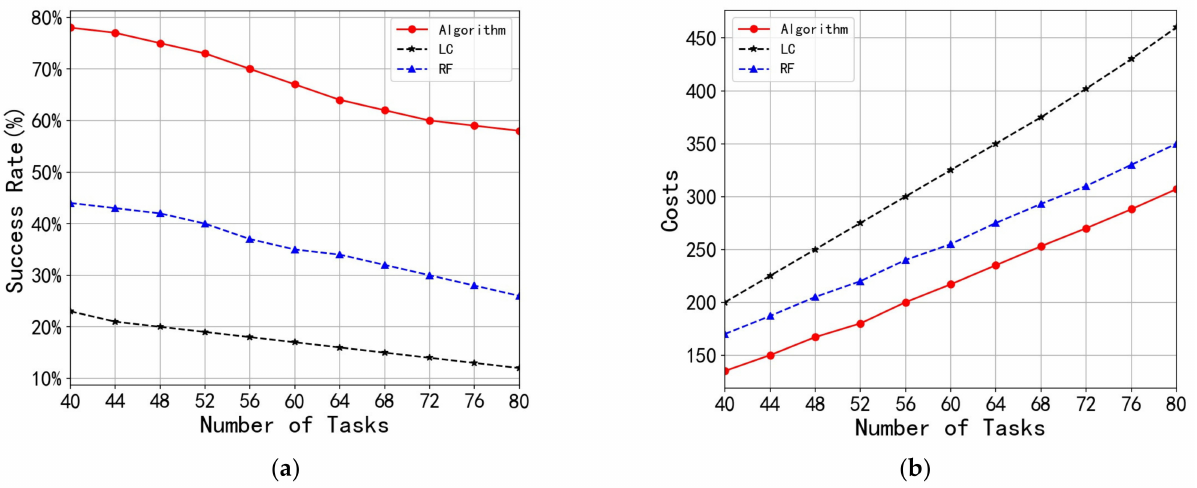
Figure 6. Simulation results with diverse number of tasks. ( a ) Task successful rate under diverse number of tasks, and ( b ) execution cost under diverse number of